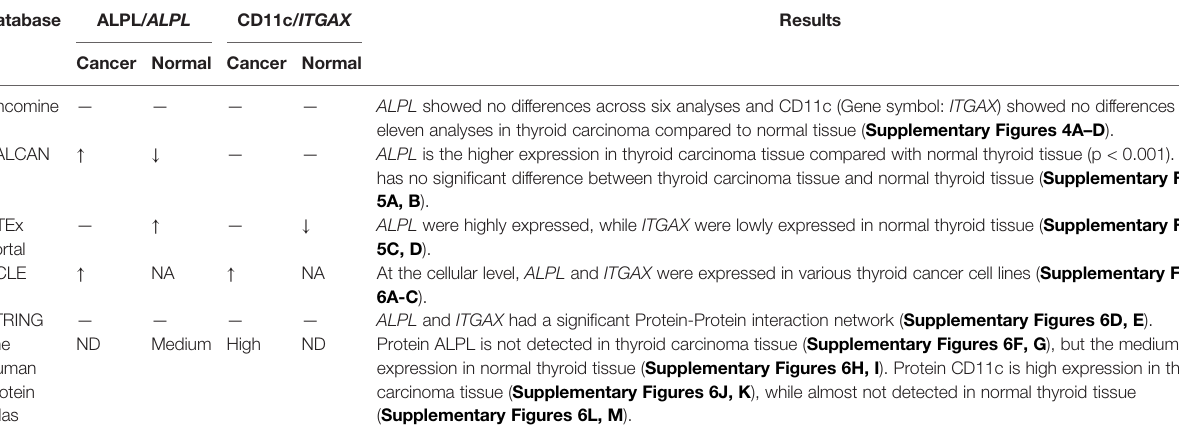
TABLE 3 | Summary of multidimensional external validation results based on multiple databases.